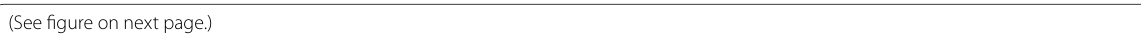
duplicate(See figure on next Fig. 3 Cell growth, glucose and lipid production of T. cutaneum MP11 under different salinities. Conditions: a fresh water, b 1.0% salinity, c 3.5% salinity, d 4.4% salinity, e 6.0% salinity, other fermentation conditions were the same as T. cutaneum . ACCC 20271. All experiments were performed in